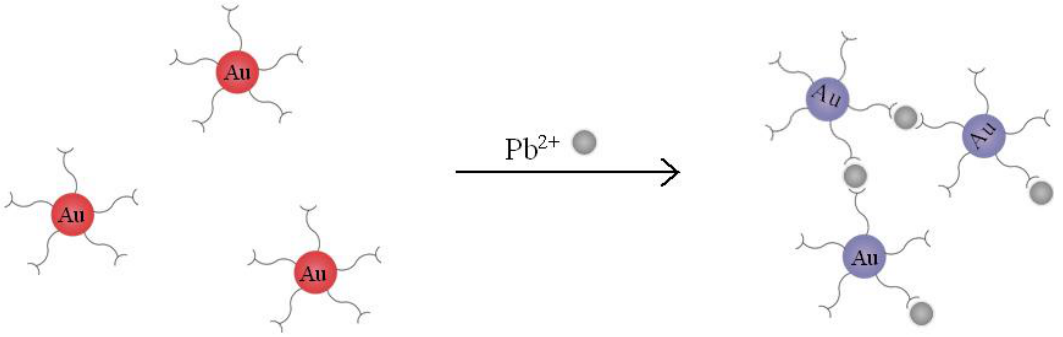
Figure 1. Schematic illustration of the chelation mechanism of Pb 2+ ions and